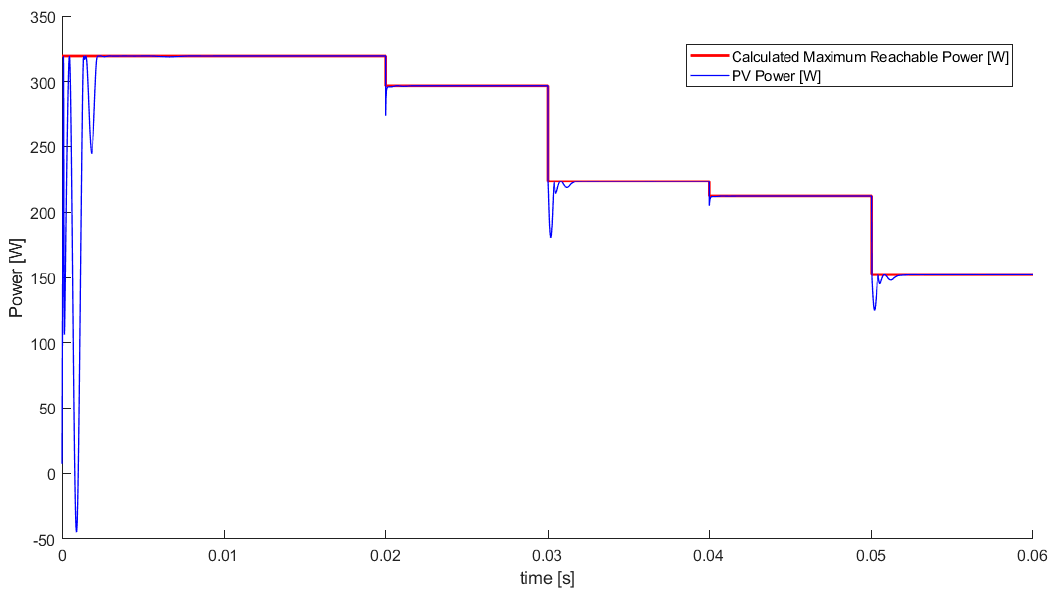
Figure 10. Evolution of PV power over time. Energies 2020 , 13 , x FOR PEER REVIEW